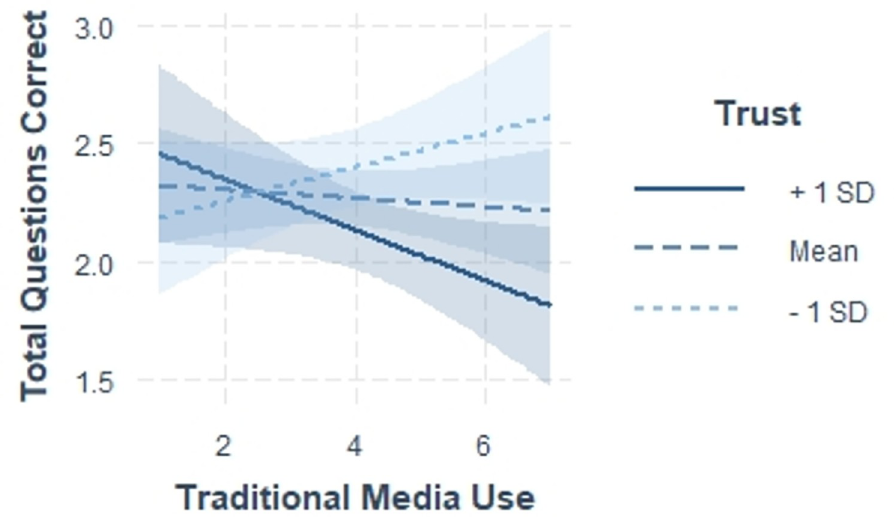
Fig 1. Relationship between traditional news media and COVID-19 questions correct by trust. This figure depicts how trust in government leaders moderates the relationship between traditional news media consumption (1 = Never to 7 = Every day) and the number of COVID-19 questions correct. Trust = Trust in Government Leaders’ knowledge of COVID-19.